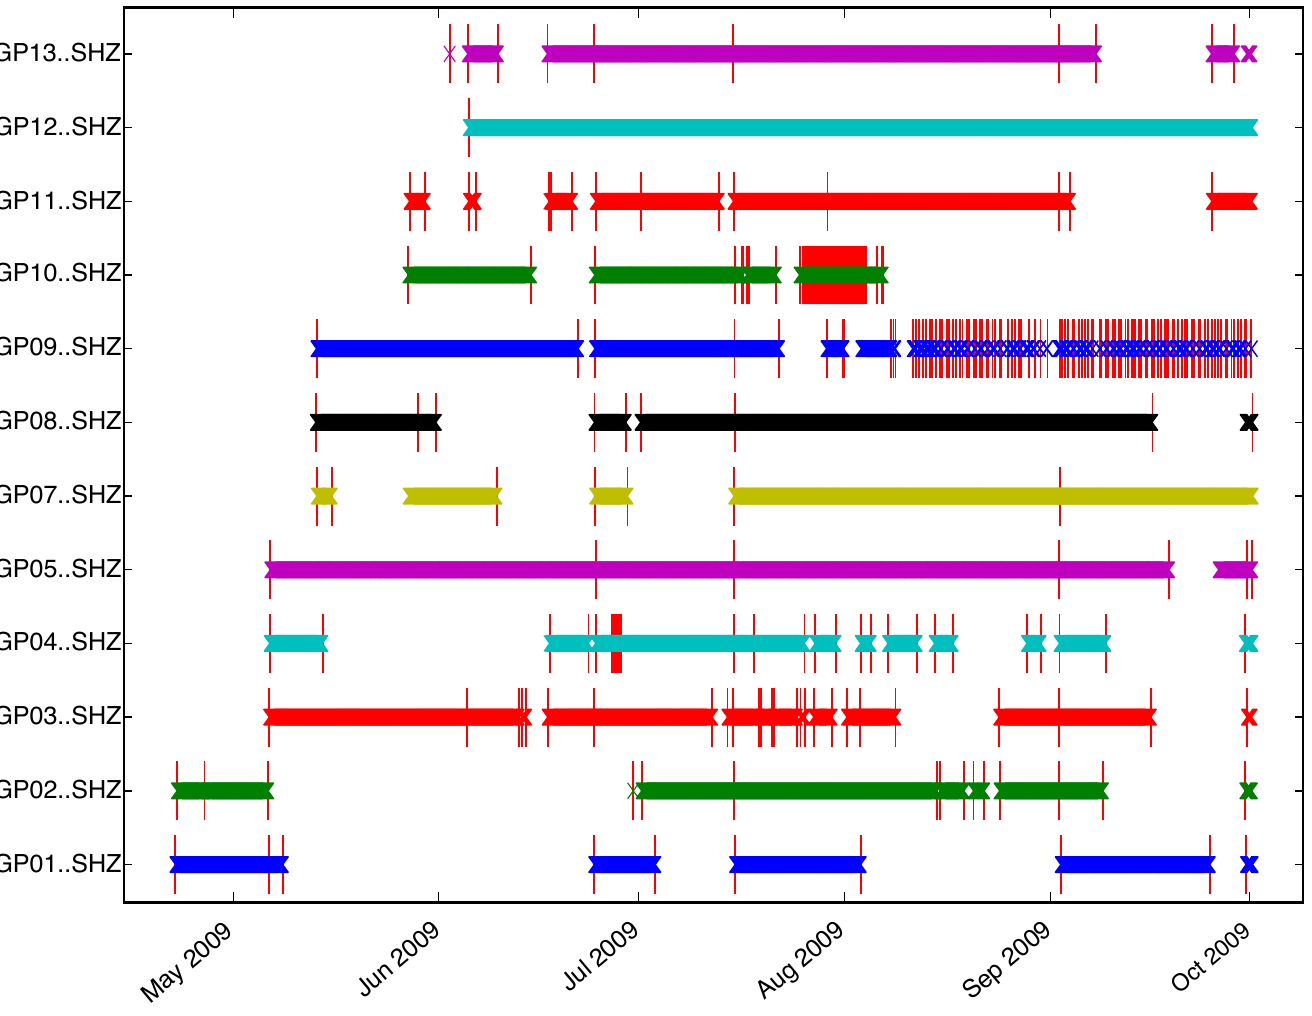
Figure 11. An overview plot for the data of a temporary network that consists of 12 stations and runs for about 5 months, created with obspy-scan. The data coverage for each station is presented in a separate line. Gaps in data availability are indicated by vertical red lines.